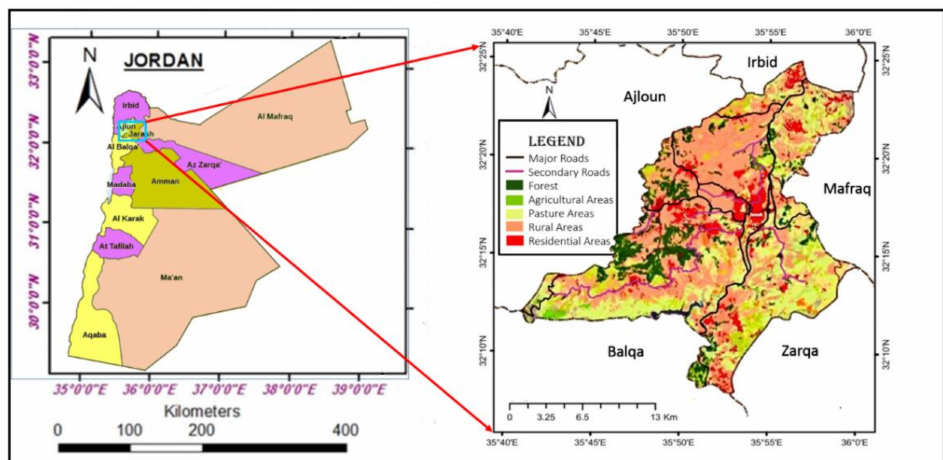
Figure 1. Location map of the study